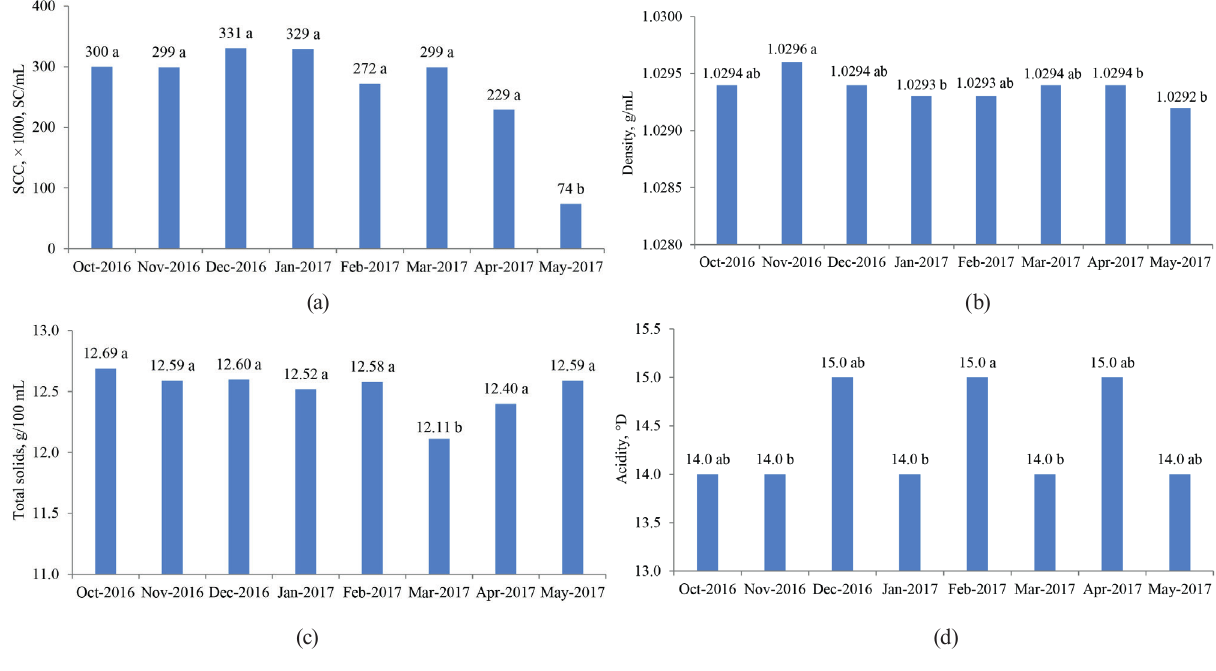
Figure 7 Dependence of average values of (a) SCC (SC/mL), (b) density (g/mL), (c) total solids (g/100 mL), and (d) acidity (°D) on the month of sampling. Equal letters mean no significant justified ( P <